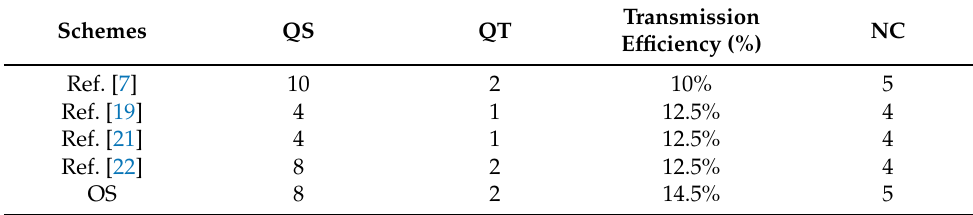
Table 8. Resampling error value vs. cross validation error